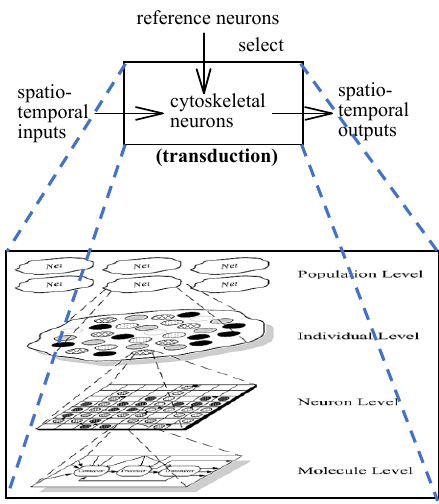
Figure 1. Architecture of the ANM system.